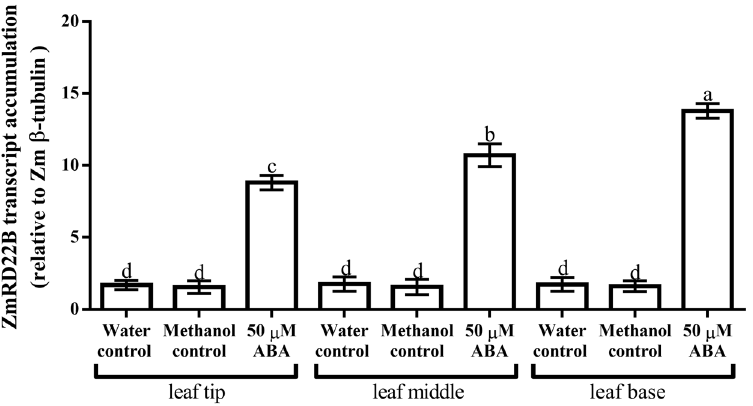
Figure 5. Expression of ZmRD22B in various regions of leaves in response to ABA treatments. Transcript accumulation of ZmRD22B, relative to Zm β -tubulin, in various leaf regions of the 2 nd youngest leaves of ABA- treated maize seedlings were measured by qRT-PCR. Leaf regions examined were the tips of leaves, middle of the leaves and the base of the leaves. Error bars signify standard errors of means from three independent experiments, bars with the same letters are statistically similar, where p < 0.05.